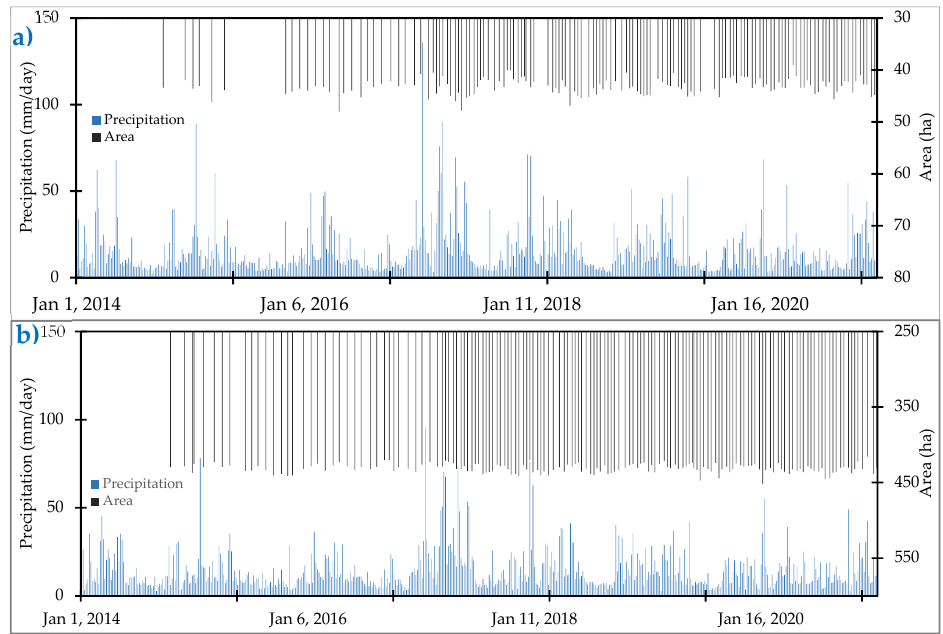
Figure 12. Daily distribution of precipitation for ( a ) Burlan and ( b ) Pomacochas lakes.